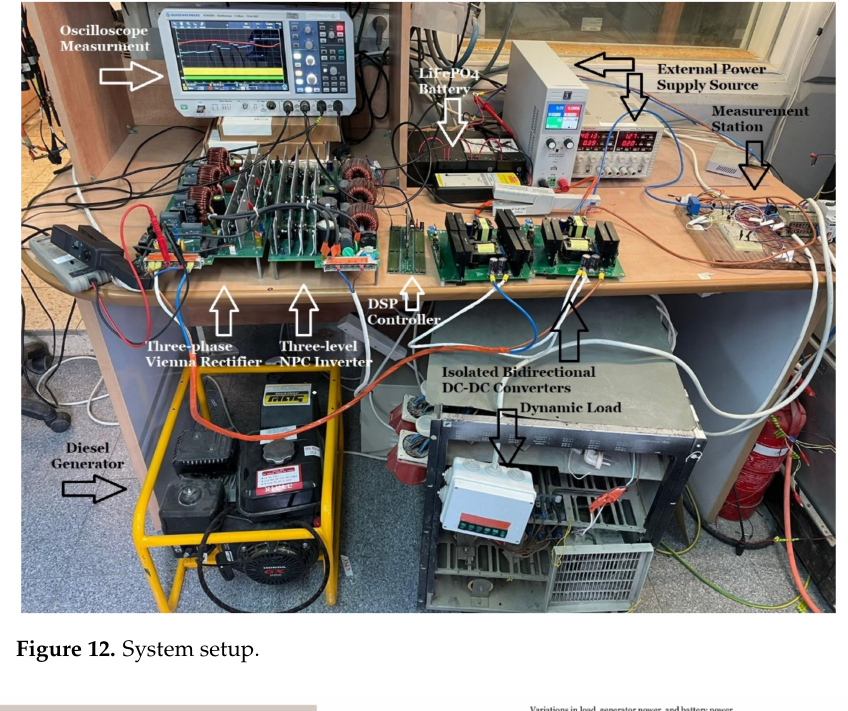
Figure 12. System setup.